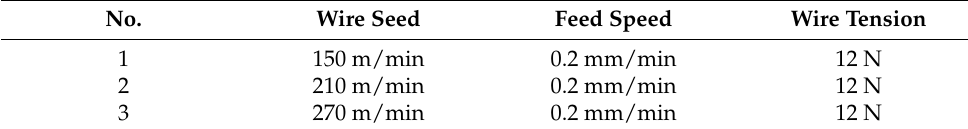
Figure 3. The process of resin bonded diamond wire sawing silicon ingot. Table 1. The processing parameters of wire sawing experiment.